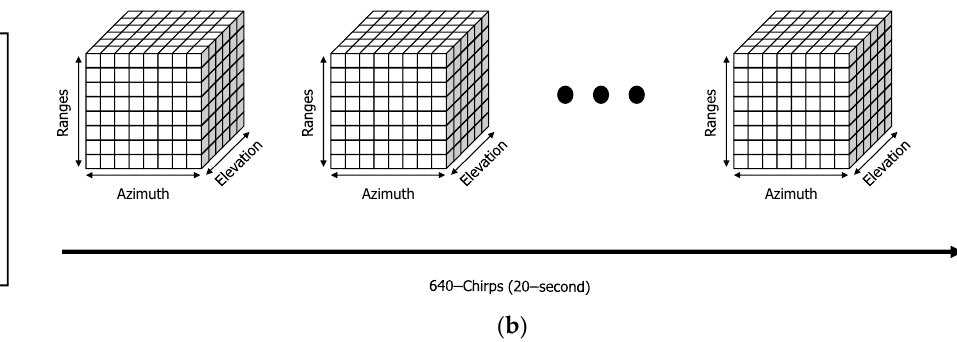
Figure 1. Scenario for monitoring vital signs of the patient lying on the surgical bed. ( a ) The used radar module; ( b ) is side – view; ( c ) and top – view.